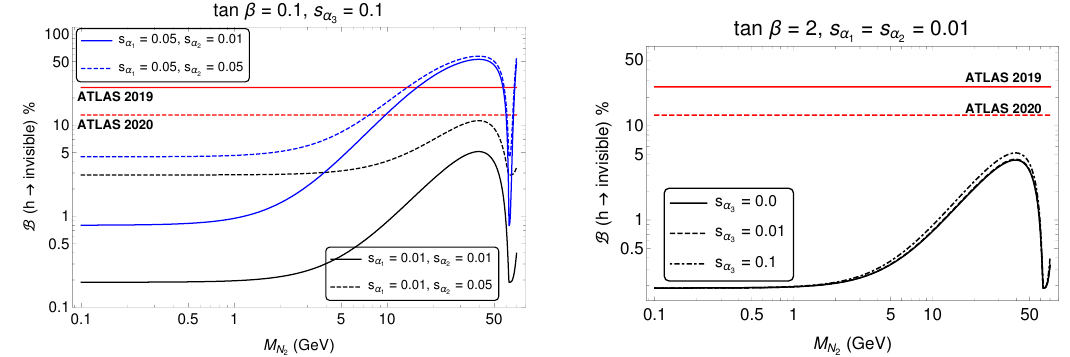
for two different values of s α 2 1